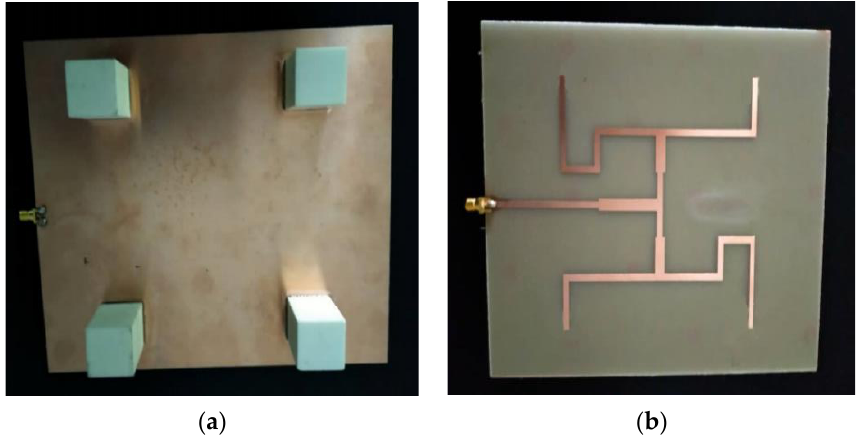
Figure 4. Fabricated prototype. ( a ) Front view; ( b ) back